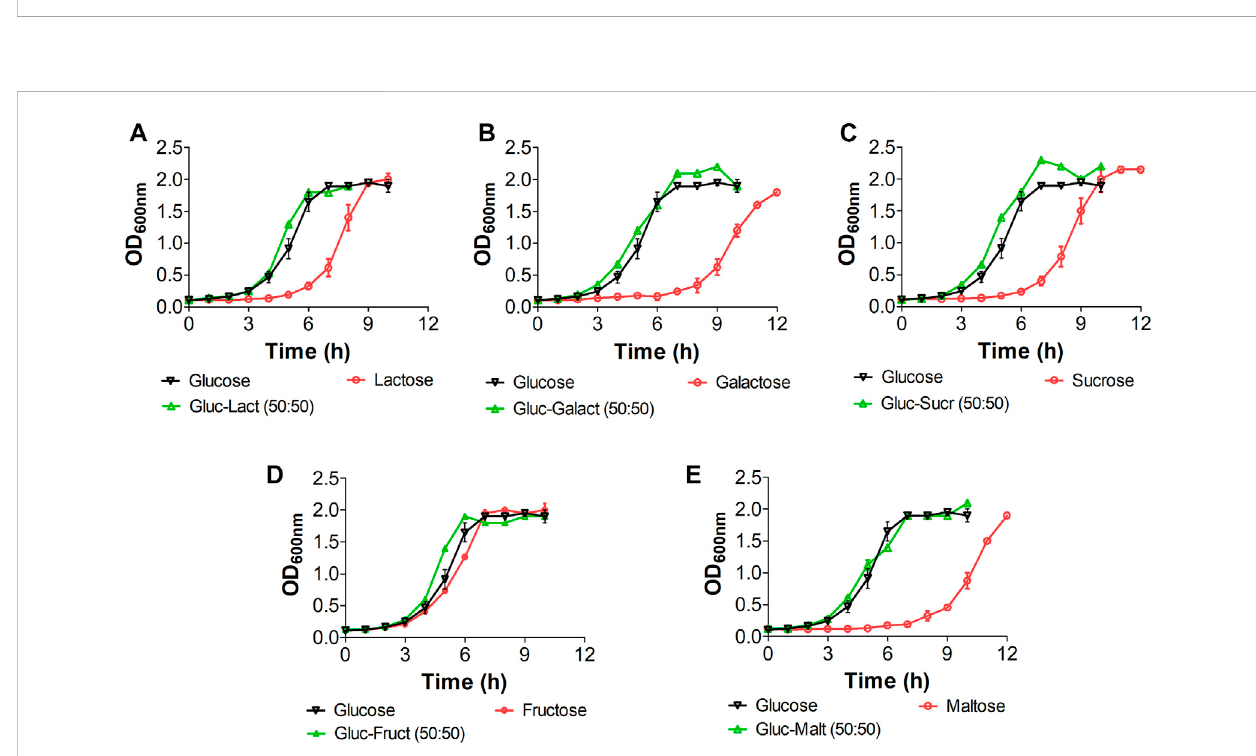
FIGURE 3 Growthkineticof E.coli Winmixsugarswithglucoseforstudyingdiauxicgrowth.Allmixandpurecarbonsourcewereusedatof2 g/L.Verticalbars representstandarddeviationandlinesareaguidefortheeye. (A) :Kineticwithlactose, (B) :kineticwithgalactose, (C) :kineticwithsucrose, (D) :kineticwith fructose, (E) : kinetic with